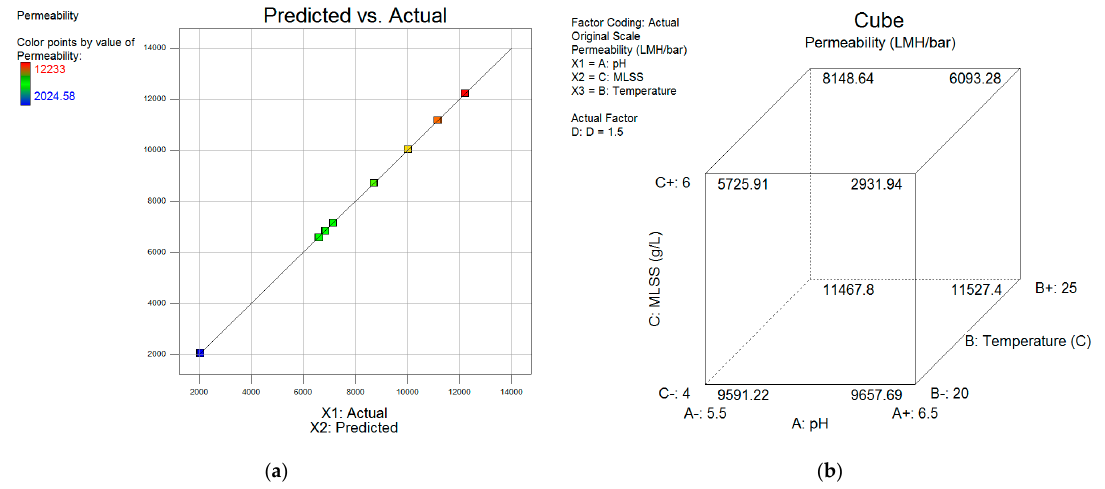
Figure 17. Model graphs of the factorial design: ( a ) predicted vs. reference plot; ( b ) cube plot, k = 3, D = 1.5 µ mole